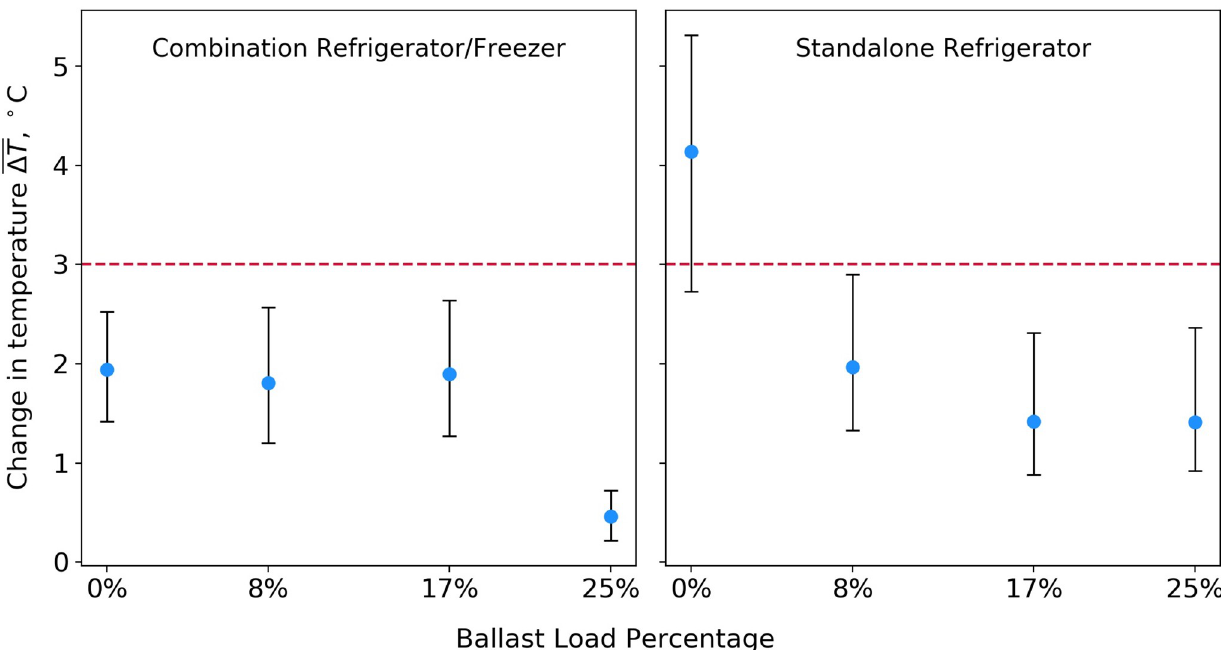
Fig 4. Refrigerator cabinet temperature changes during defrost cycle activation at varying thermal ballast load percentages. Round blue markers indicate the average temperature rise of all monitored vaccines during each trial, and error bars show the range of these measurements, corresponding to the within-trial variation among monitored